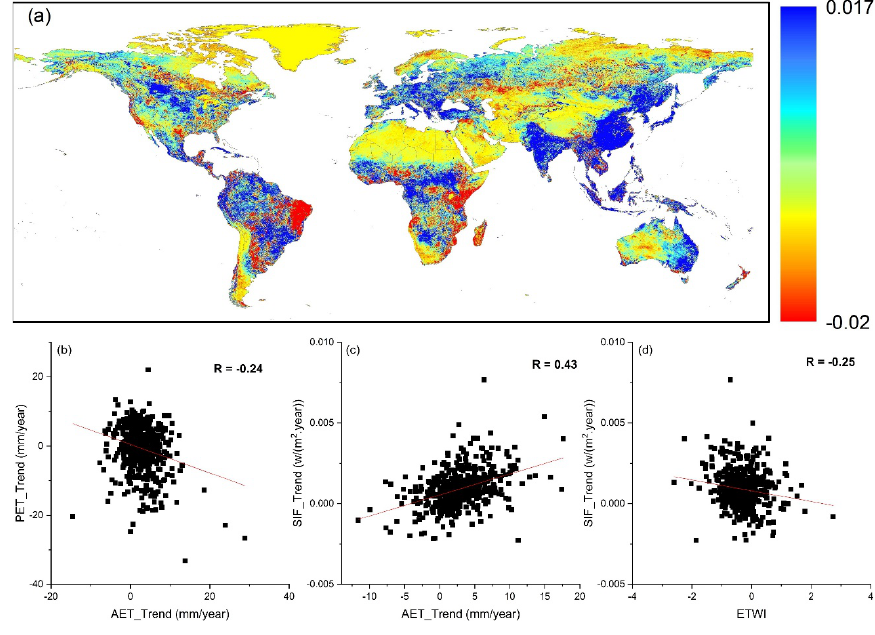
Figure 11. ( a ) SIF global trend from 2001-2017 in w/(m 2 .year); Relationship between ( b ) AET trend and PET trend, ( c ) AET trend and SIF trend, and ( d ) ETWI and SIF trend (Note that the points are sample of variables in croplands but R-value covers all data).